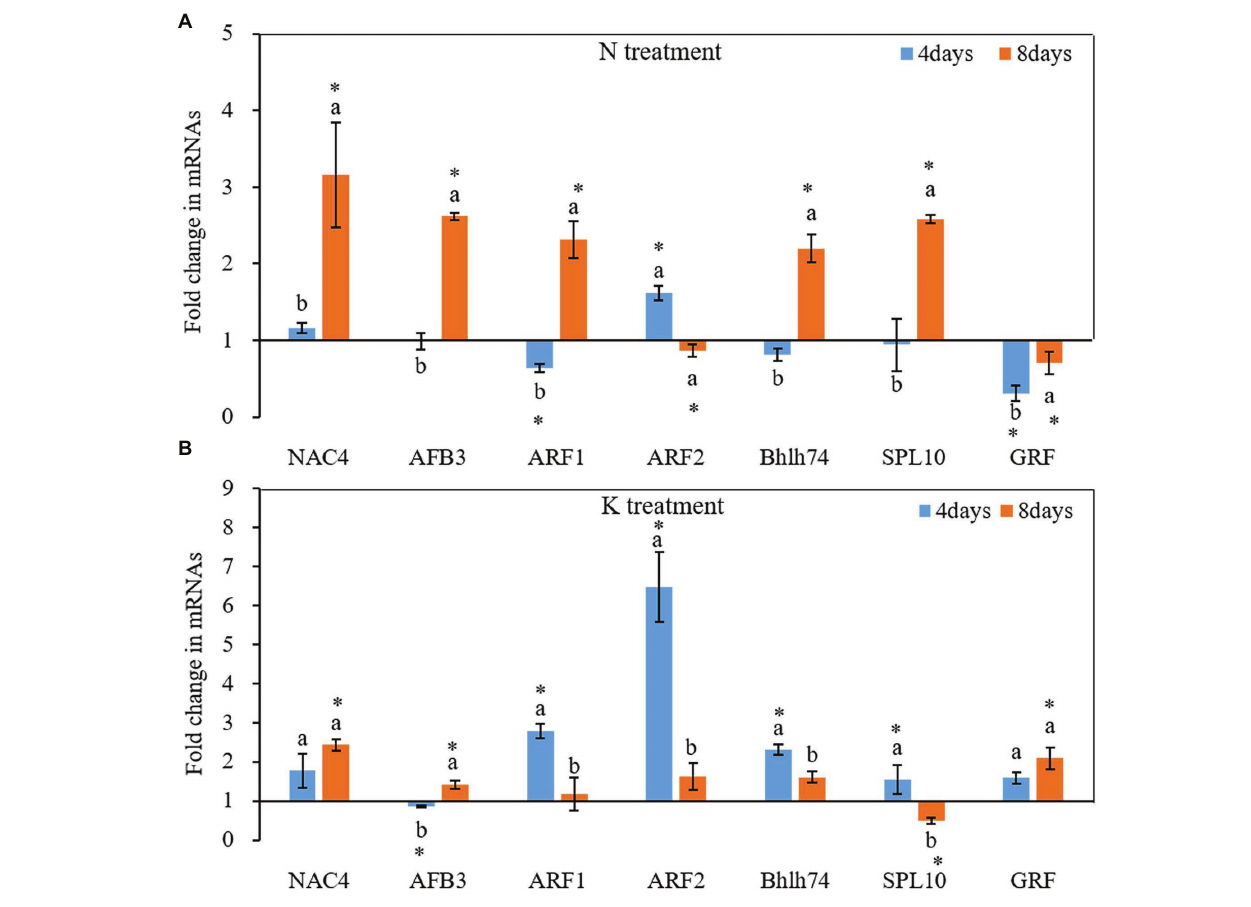
FIGURE 6 | Fold change of miRNA target gene expression between N deficiency and the controls (A) and between K deficiency and the controls (B) in the root of peanut seedlings, respectively. The different letters on the bars indicate significant differences in the fold change of miRNA target expression between 4 and 8 days of treatment according to the LSD test ( p = 0.05). A value of p less than 0.05 was considered as a significant difference between N (or K) deficiency and the controls, which marked as ∗ in the graphs. N, nitrogen; K, potassium; and LSD, least significant